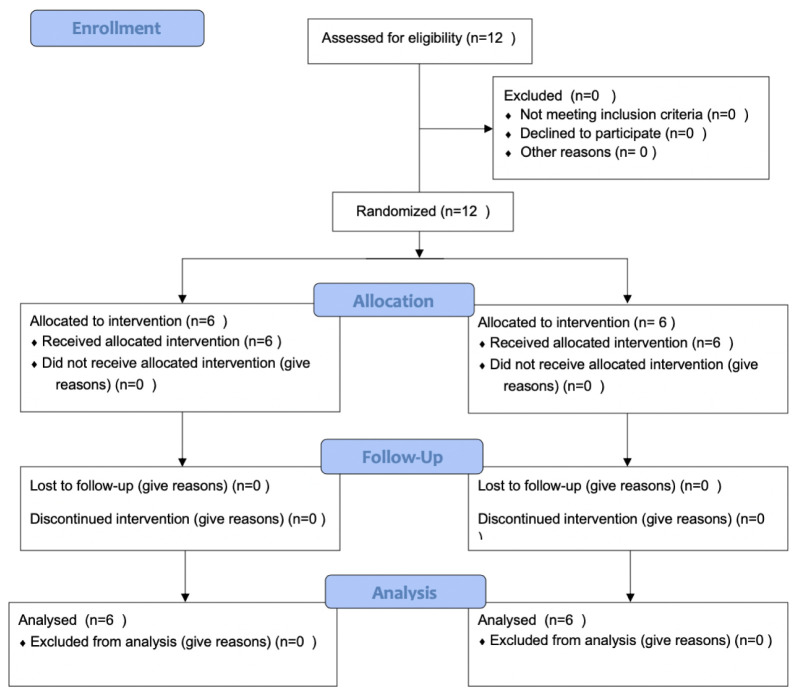
Study flow diagram.